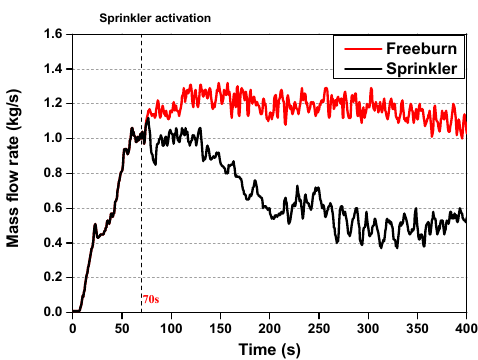
Figure 12. Variation in the mass flow rate of the smoke layer through the right doorway.